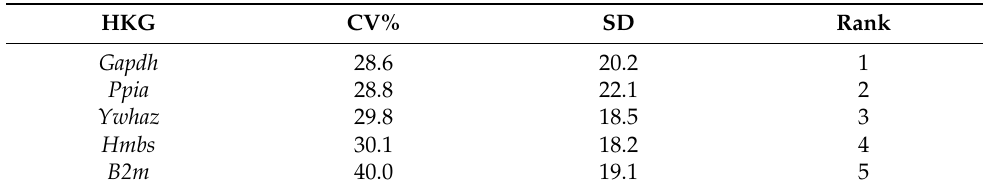
Table 1. Expression stability of candidate reference genes in sensorimotor region in TBI rats treated with xenon, evaluated using coefficient of variation (CV).